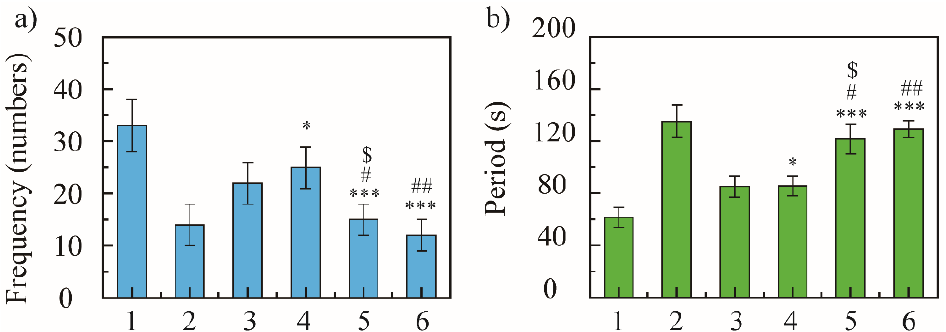
Figure 4. Cough-relieving effect of naringenin nanosuspension (NRG-NSps) on mice: cough frequency in 5 min ( a ) and cough incubation time ( b ), n = 10. 1: Saline group, 2: dextromethorphan hydrobromide group (15 mg/kg), 3: NRG group (30 mg/kg), 4: NRG-NSps group (10 mg/kg), 5: NRG-NSps group (30 mg/kg), and 6: NRG-NSps group (50 mg/kg). * p < 0.05 and *** p < 0.001 vs. saline group; # p < 0.05 and ## p < 0.01 vs. NRG-NSps group (10 mg/kg); $ p < 0.05 vs. NRG group (30 mg/kg).